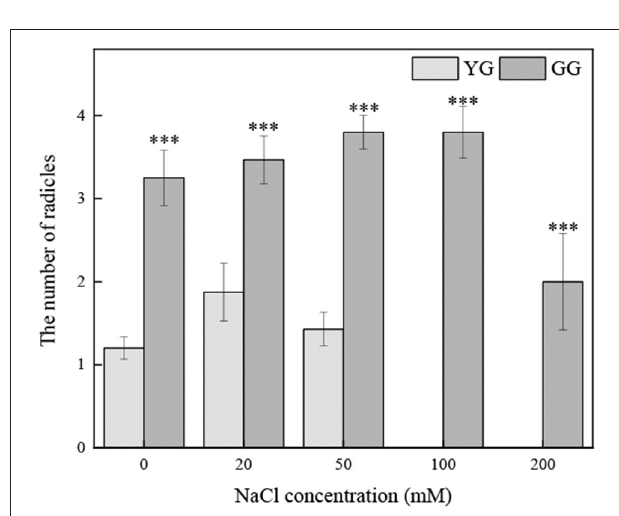
FIGURE 7 | Effects of salt stress on the number of radicles of seedlings grown from different of L. chinensis ecotypes. There were twenty replicates for each treatment. Values are presented as means ± standard error (SE). * , ** , *** Indicate significant differences between the different ecotypes under the same NaCl concentration at 0.05, 0.01, and 0.001 level respectively, and “ns” indicates no significant differences.